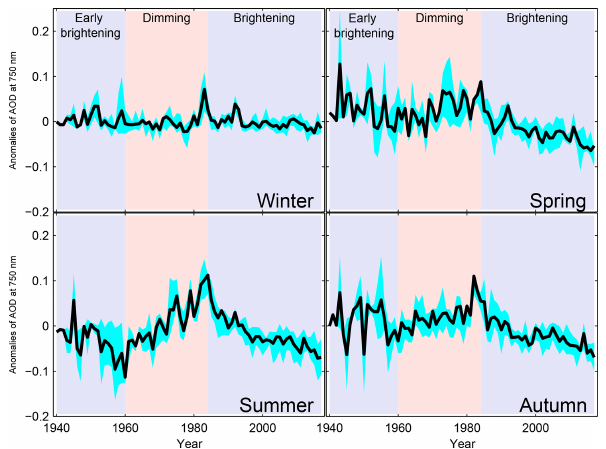
Figure 11. Evolution of the mean of seasonal anomalies of AOD for all stations given in Table 1. The cyan area refers to the range between first and third quartiles of the different series for each year. The light purple and misty rose bands indicate (early) brightening and dimming periods,